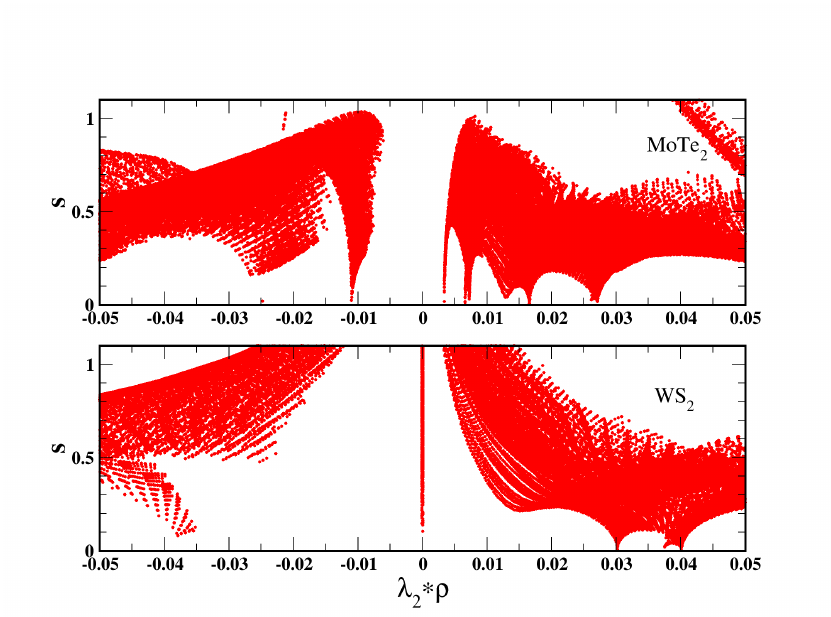
Figure 5. Plot of the non-covalent interaction(NCI) indicator [93] (density vs. reduced gradient) for MoTe 2 and WS 2